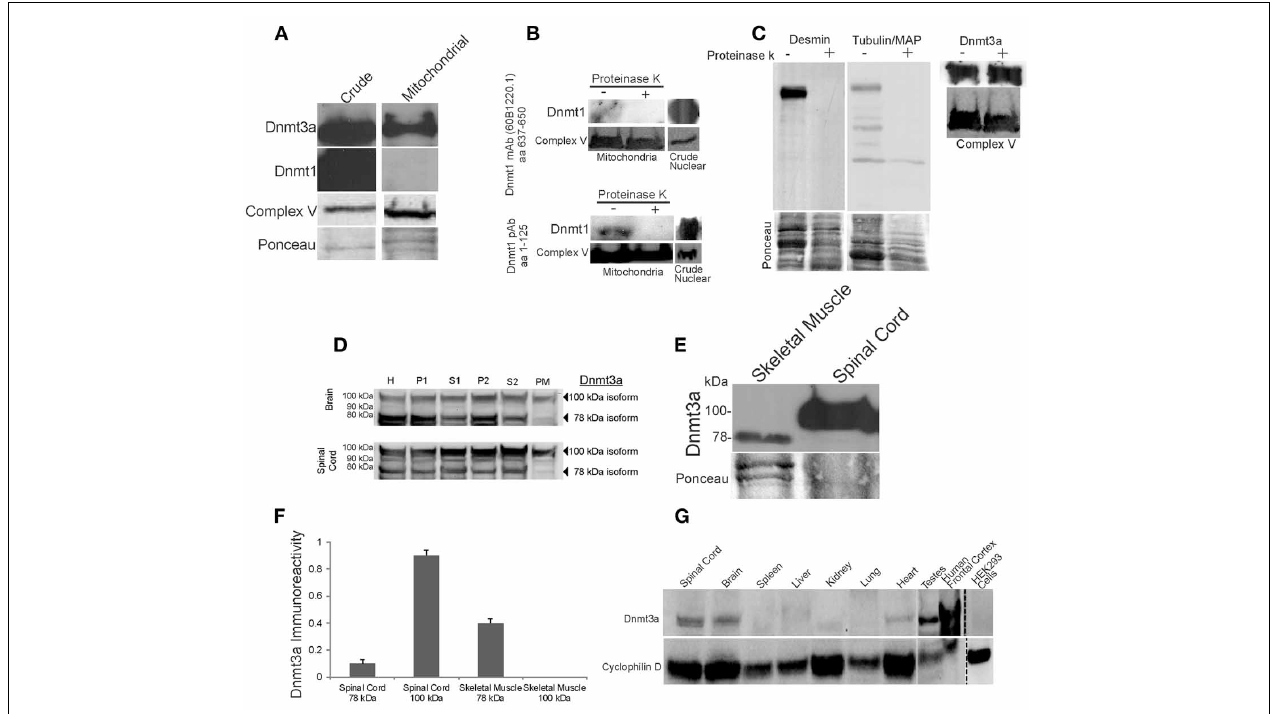
FIGURE 2 | Dnmt3a is present in skeletal muscle and CNS mitochondria of adult mouse and human. (A) Western blots showing that Dnmt3a, but not Dnmt1, is present in adult mouse skeletal muscle mitochondria. Dnmt1 was present in crude tissue fractions but was undetectable in pure mitochondrial fractions even with prolonged overexposures as shown. Western blot for the mitochondrial marker complex V is used to verify mitochondrial enrichment of the fraction. Ponceau S-stained membrane is used to show protein loading. (B) Experiments that establish that Dnmt1 is bound to the outer surface of mitochondria. Freshly isolated intact skeletal muscle mitochondria were treated ( + ) with agarose-conjugated proteinase K to digest surface-bound proteins or were not treated with proteinase K ( − ). Mitochondria were lysed and proteins were fractionated by SDS-PAGE and western blotted for Dnmt1 using two different antibodies that detect different amino acid (aa) domains of the protein. Protein loading was revealed by reprobing the blots for complex V. Crude nuclear fractions were used as a positive control. (C) Experiments that establish that Dnmt3a is within mitochondria and not merely bound to the outer surface of mitochondria. Freshly isolated intact skeletal muscle mitochondria were treated with agarose-conjugated proteinase K to digest surface-bound proteins. The efficacy of digestion is shown by the loss of desmin and tubulin/MAP immunoreactivities in the treated samples, but Dnmt3a immunoreactivity was not attenuated by proteinase K digestion. Protein loading is shown by Ponceau S staining of membranes. Mitochondrial enrichment is shown by complex V immunoreactivity. (D) Adult mouse